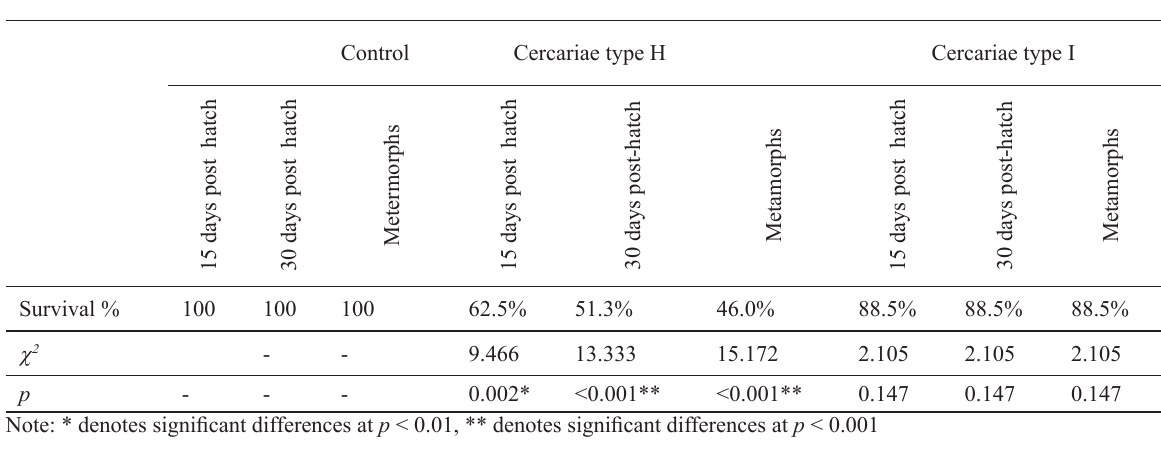
Table 1: Survival of tadpoles of Polypedates cruciger at 15 days, 30 days post–hatch and at metamorphosis after multiple exposure to cercariae types H and I (exposure at Gosner stage 27/28).